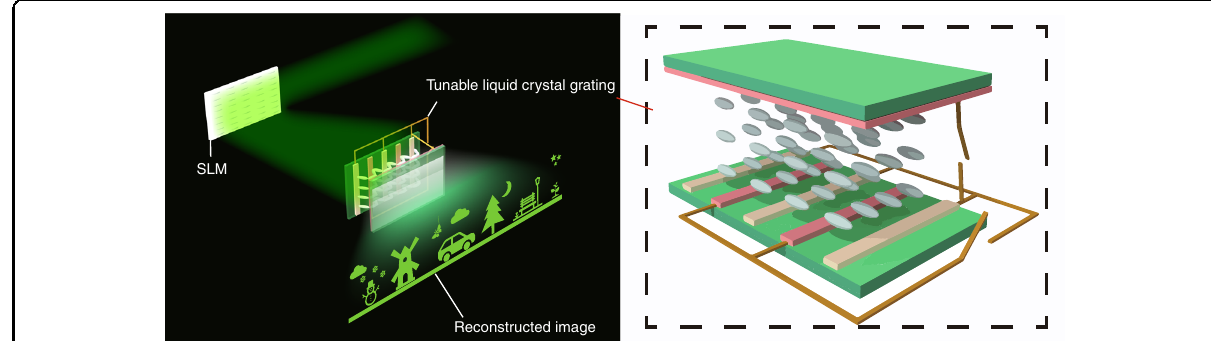
Fig. 1 Concept of the proposed